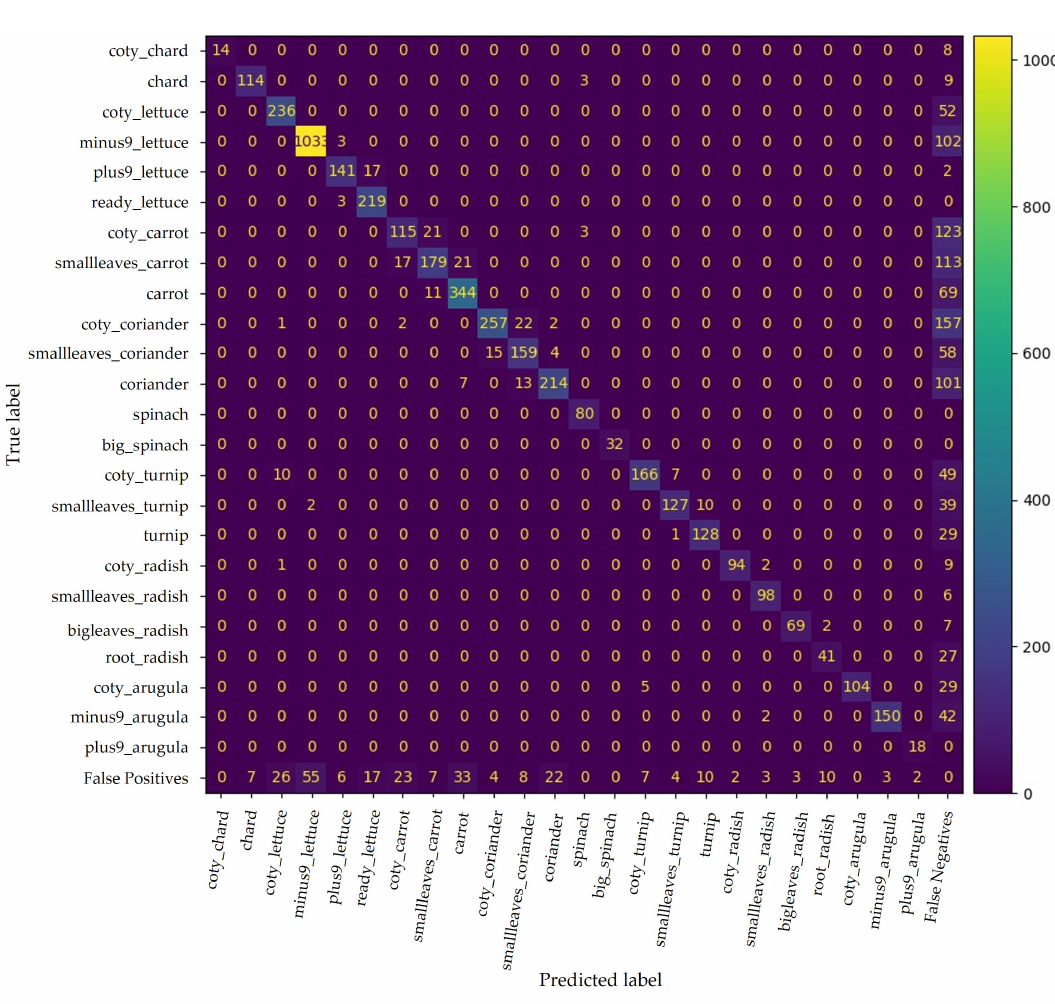
Figure 9. Evolution of the F1-score with the variation of the confidence threshold for YOLO v4 in the validation set without augmentation.